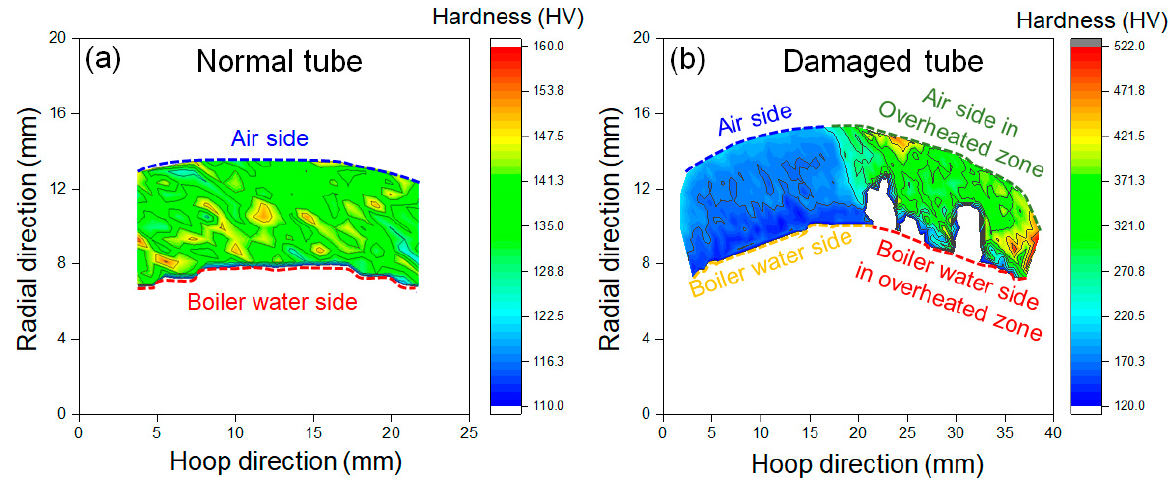
Figure 6. Hardness contour mapping results for ( a ) a normal tube and ( b ) a damaged tube.